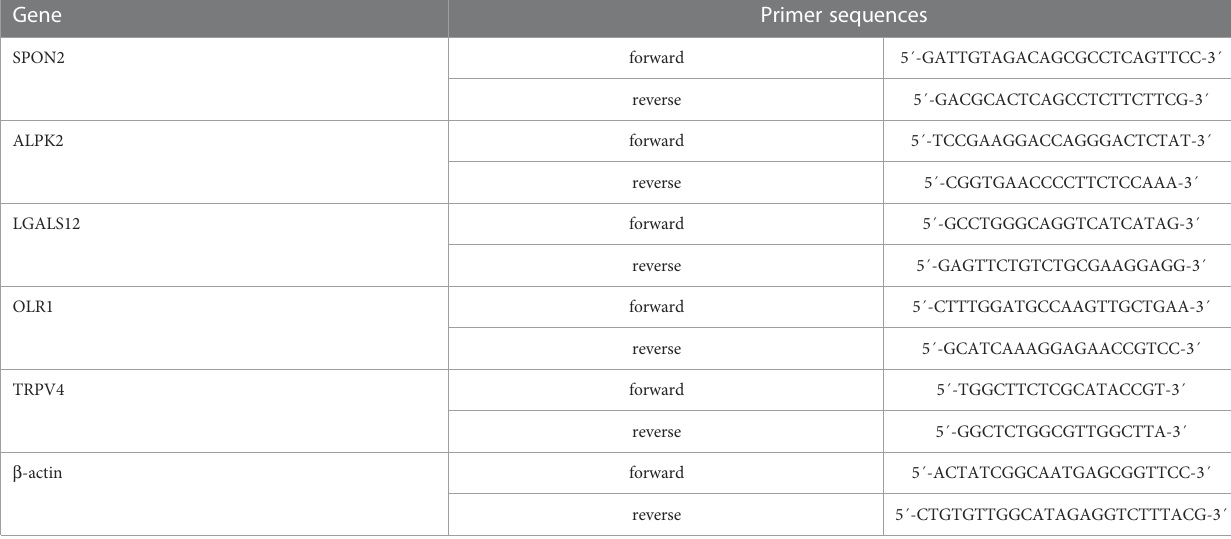
TABLE 1 qPCR primer